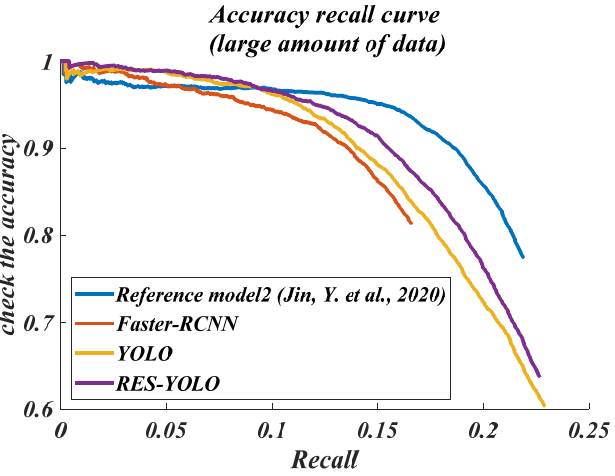
Figure 14. Precision and recall (PR) curve in small data set (large amount of data) [21].